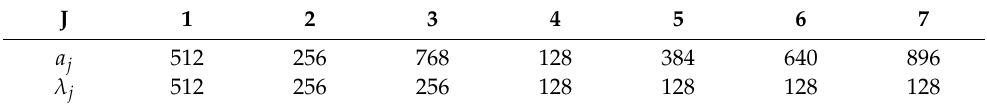
Table 1. Fixed parameters of MeLU with maxInput = 256 (these are the same values as in [61]).